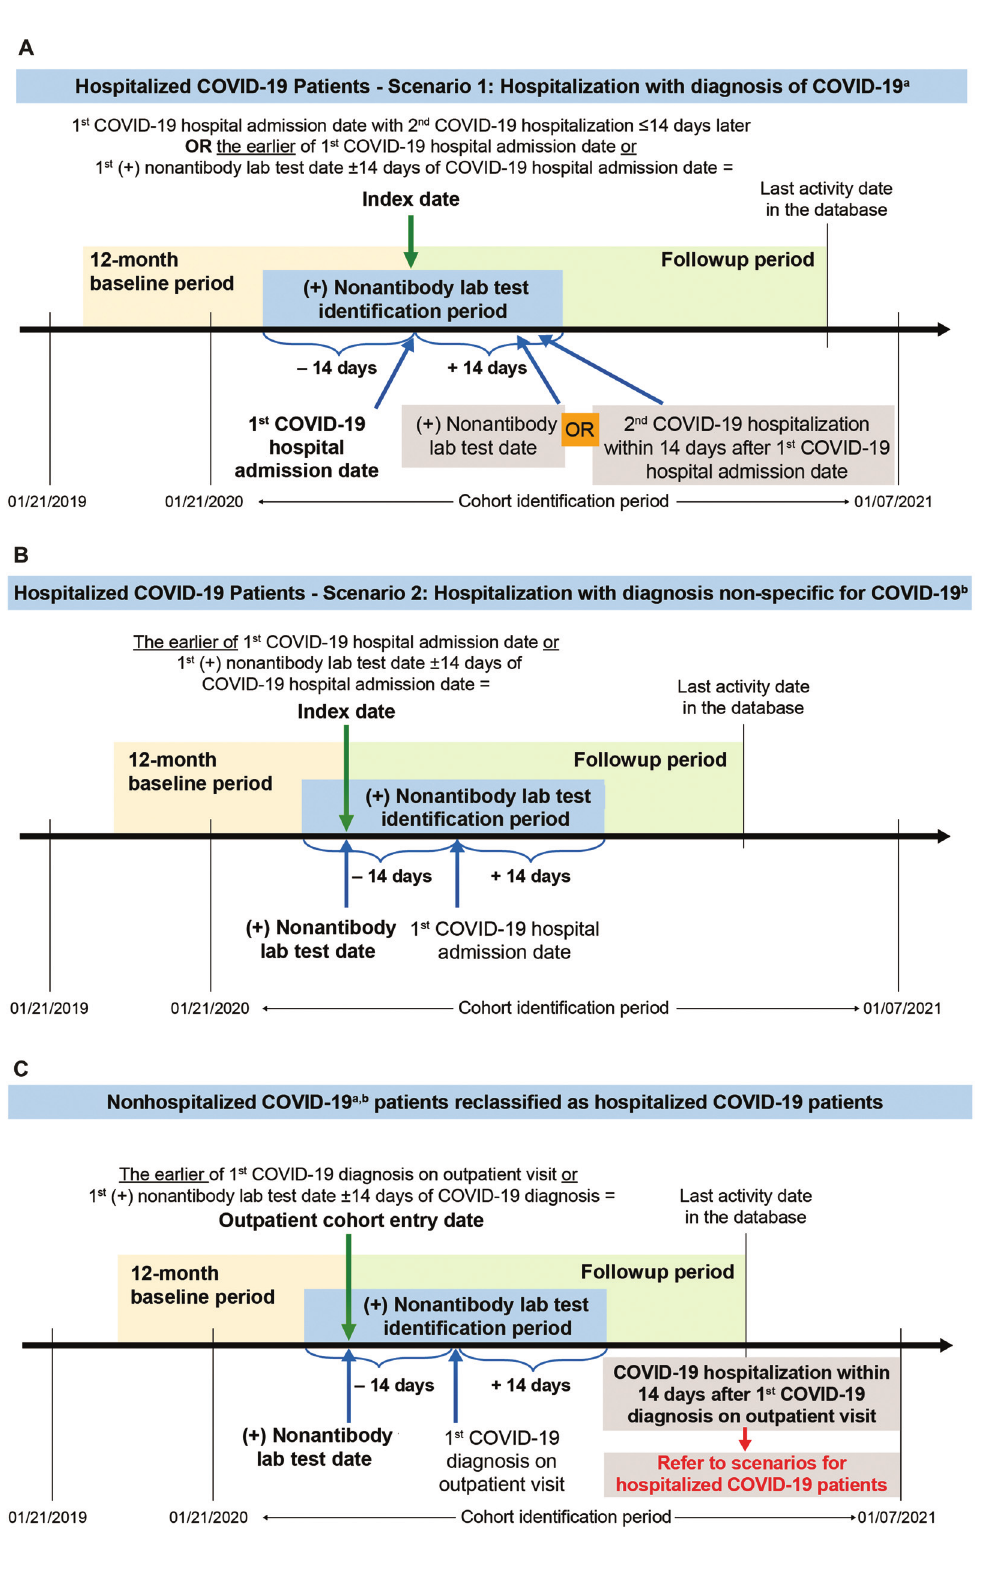
Fig. 1 Study design for ( A ) patients hospitalized with a diagnosis of COVID-19, a ( B ) patients hospitalized with a diagnosis nonspeci fi c for COVID-19, b and ( C ) nonhospitalized COVID-19 patients a,b who are hospitalized within 14 days for COVID-19. Examples of timelines are given, noting that patients whose index dates were later in the cohort identi fi cation period (e.g., November and December 2020) would have shorter available times for follow-up. COVID-19, coronavirus 2019; ICD-10-CM, International Classici fi cation of Diseases, 10th Revision, Clinical Modi fi cation . a De fi ned as ICD-10-CM: U07.1, B97.29, B97.21, or B34.2. b De fi ned as ICD-10-CM: J12.81, J12.89, J20.8, J22, J40, J80, J98.8, A41.89, R05, R06.02, or R50.9.